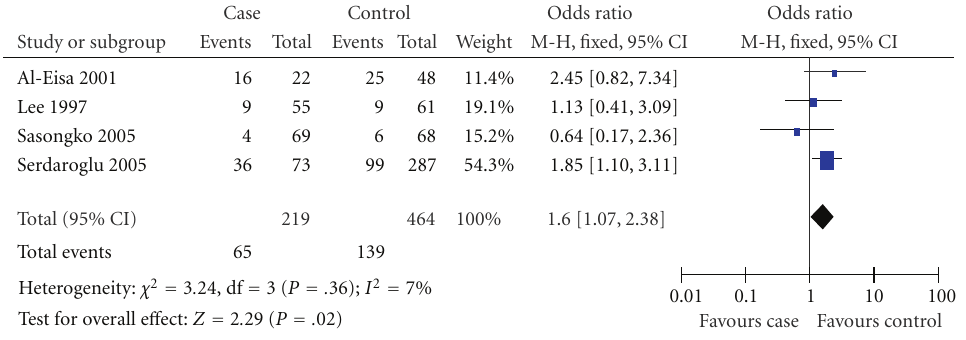
Figure 2: Association of DD genotype with MCNS susceptibility in